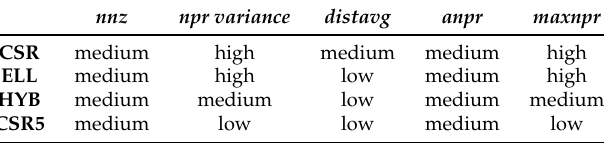
Table 2. Performance of the four sparse storage scheme against the five matrix sparsity features. nnz npr